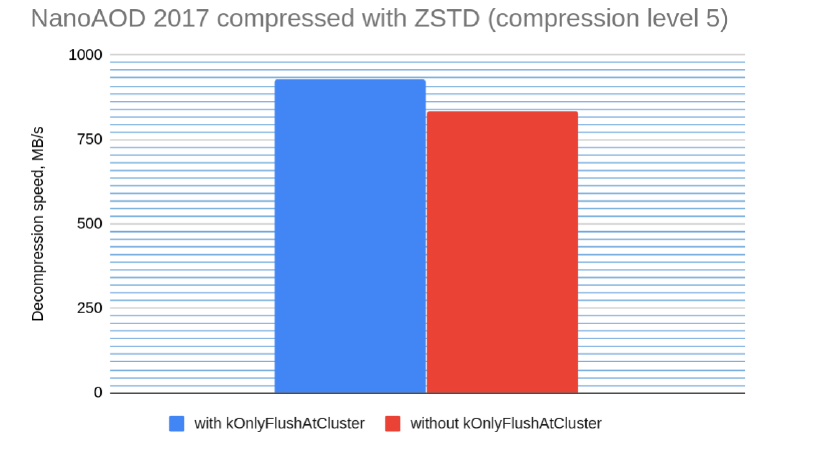
Figure 5. Comparison of decompression speed for two file samples NanoAOD 2017, with and without TTree::kOnlyFlushAtCluster